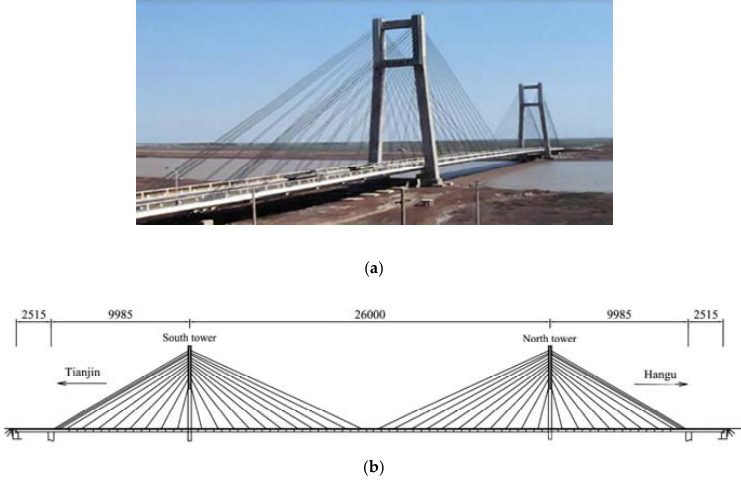
Figure 1. The Tianjin Yonghe Bridge: ( a ) general view, ( b ) main dimensions.